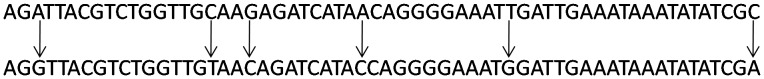
Creation of mutated sequences.Example of the 10% of mutation (6 bases) of a 60 bases sequence, creating a new sequence (bottom) from the original sequence (upper). The loci and the replacing bases are randomly chosen.